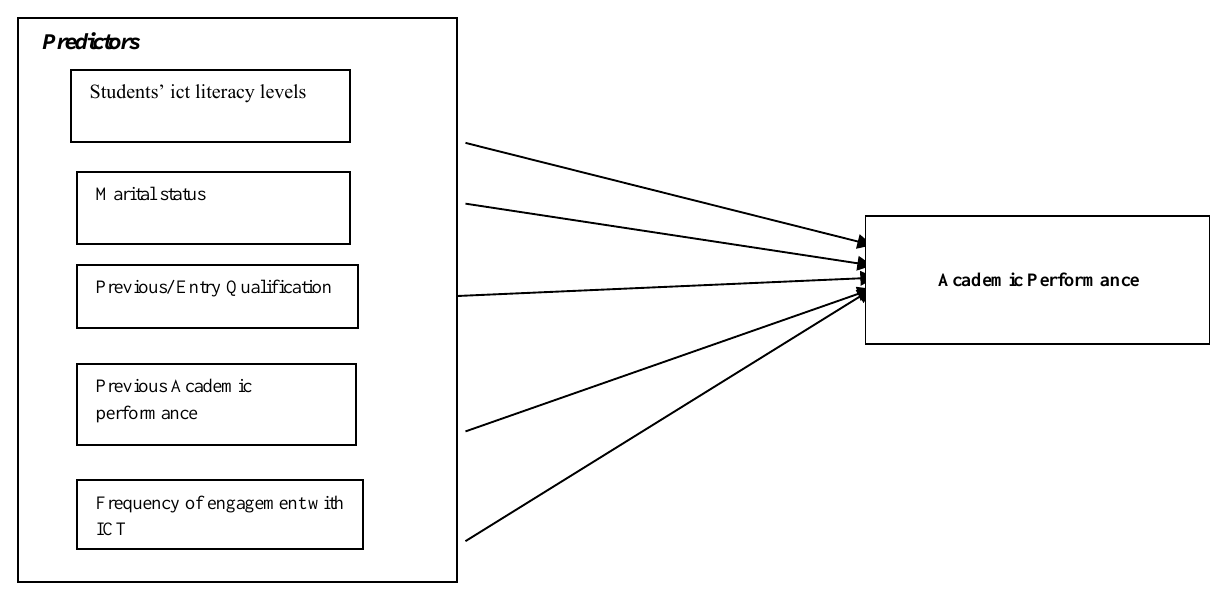
Figure 1: Predictors of Academic Performance of Distance